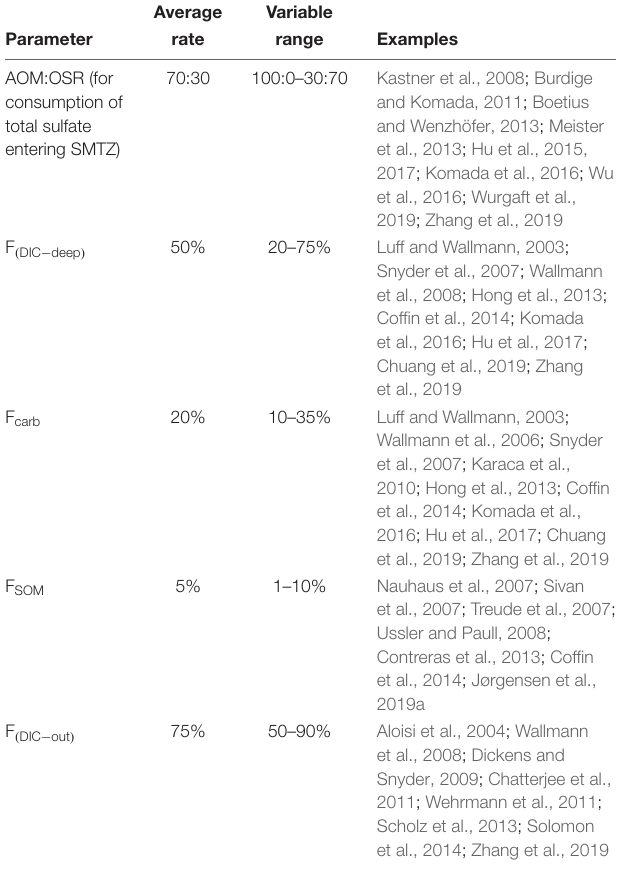
TABLE 1 | Parameters controlling the DIC fluxes at SMTZ, with their average and extended range considered in carbon flux calculation. Average Variable Parameter rate